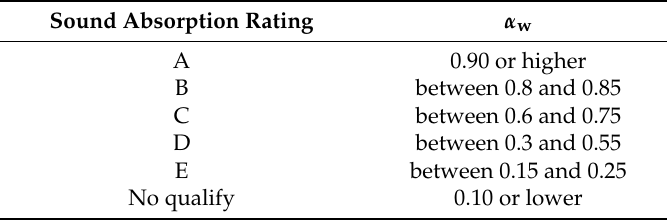
Table 1. Rating of sound absorption according to ISO 11654, 1997.